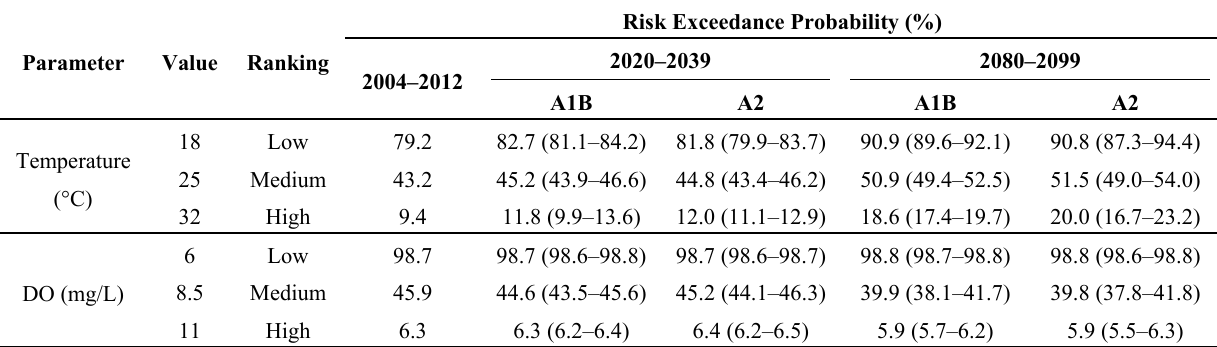
Table 4. Risk exceedance probability for the surface water temperature and DO.